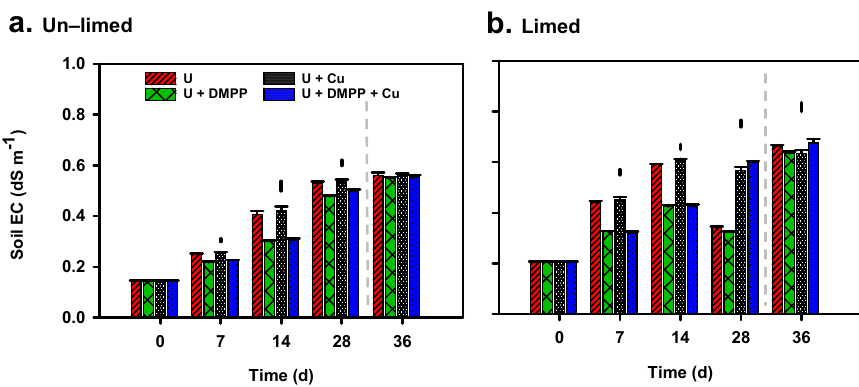
Figure 2. Changes in soil EC (1:5 soil: water) after application of urea, DMPP, and Cu in the ( a ) un- limed soil and ( b ) limed soil. The soil water was maintained at 55% WHC for the first 28 d then increased to 90% WHC for the remainder of the experimental period (as indicated by the grey broken vertical line). Data are the means of four replicates ± SE. The single vertical bars indicate the least significant differences among treatments (LSD 0.05 ).